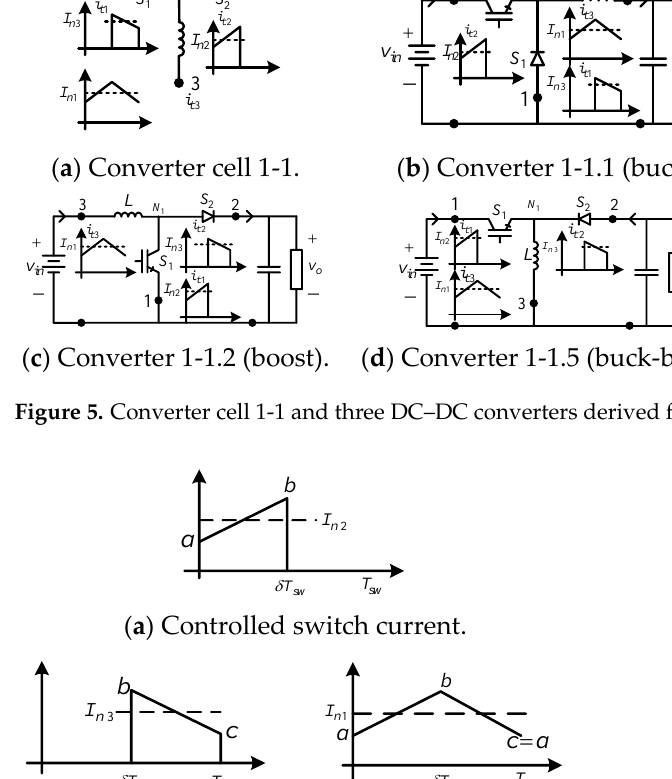
The Average, RMS, and Ripple RMS Values for Current Signals from DC–DC Converters Based on Cell 1-1